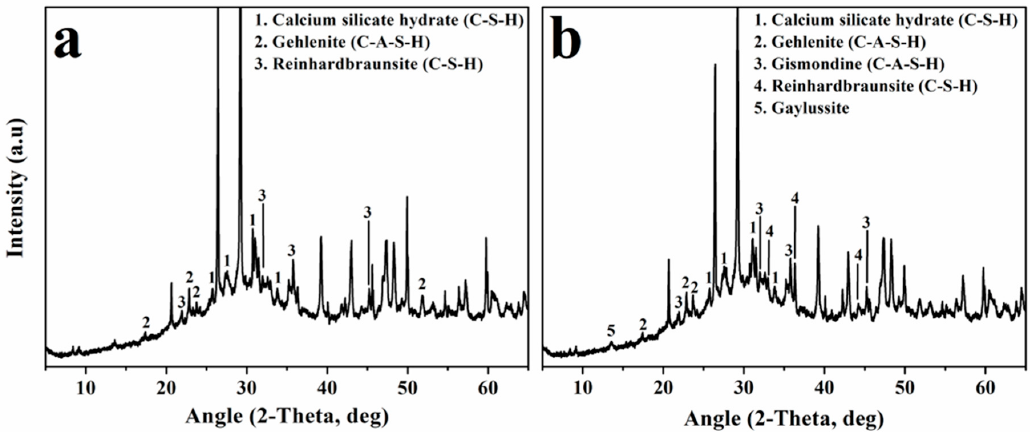
Figure 6. XRD patterns of ( a ) AA-WBA-6M and ( b ) AA-WBA-8M.